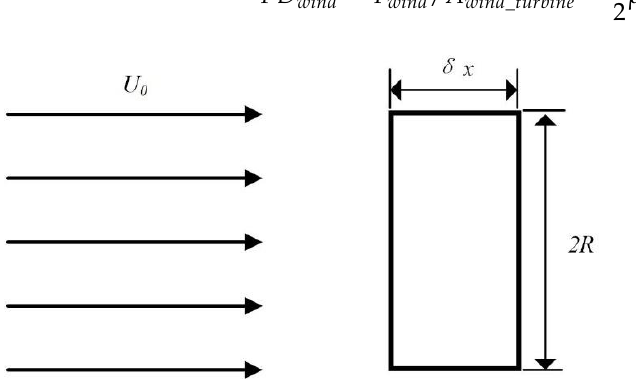
Figure 2. Side view of blade rotation.